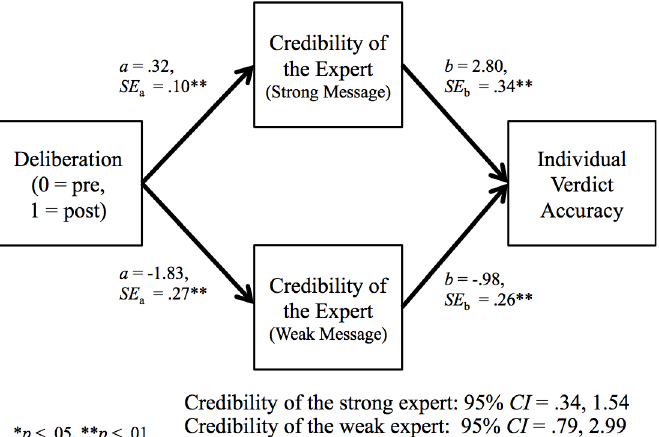
Fig 4. The indirect effect of deliberation on individual verdict accuracythrough expert